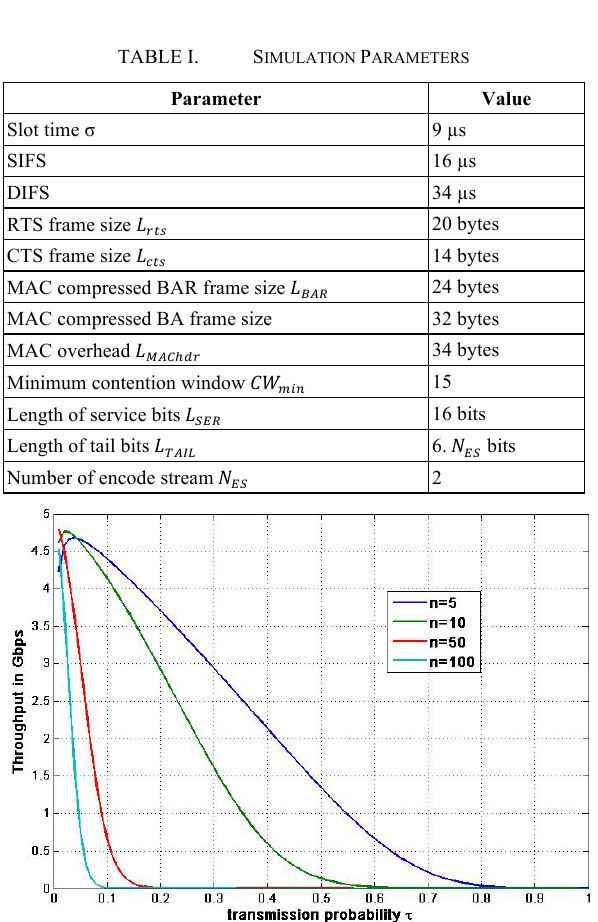
Figure 4. Throughput vs. Transmission probability